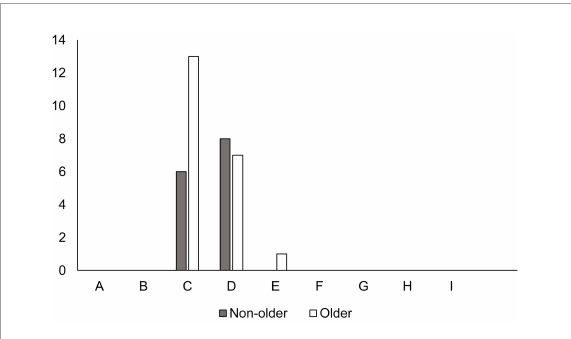
FIGURE2 Impact of falls on patients. The x-axis is classification by National Coordination Council for Medication Error Reporting and Prevention index (reference 23), and the y-axis is number of